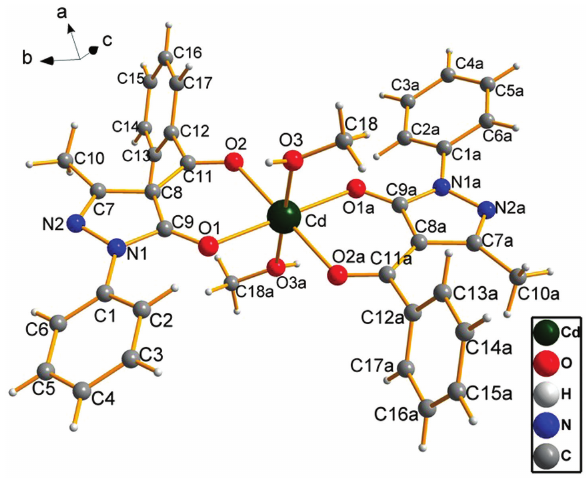
Table 1: Differences between [Cd(PMBP)